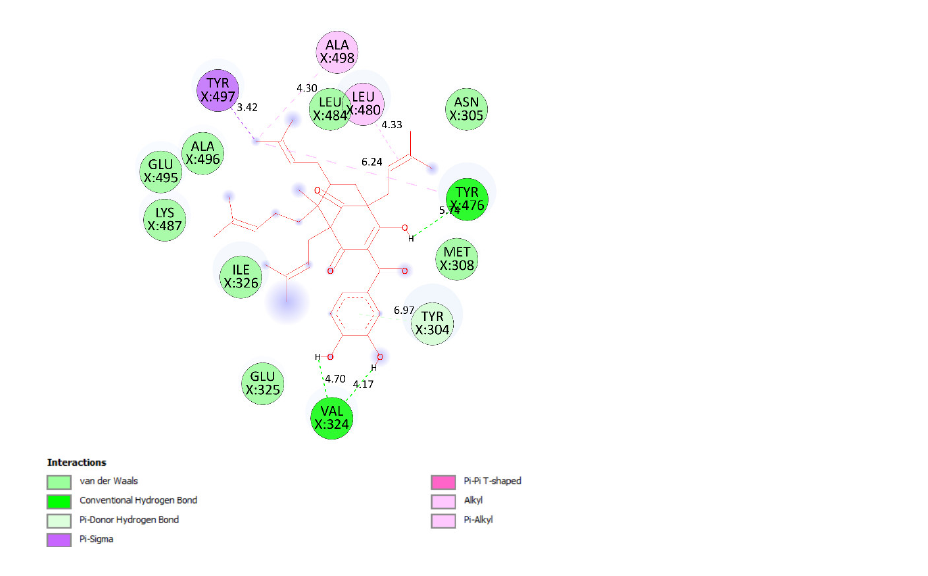
Figure 19. The hydrogen bonds from active atoms on pose 35/200 to active atoms on residual amino acids of enzyme 2VF5.